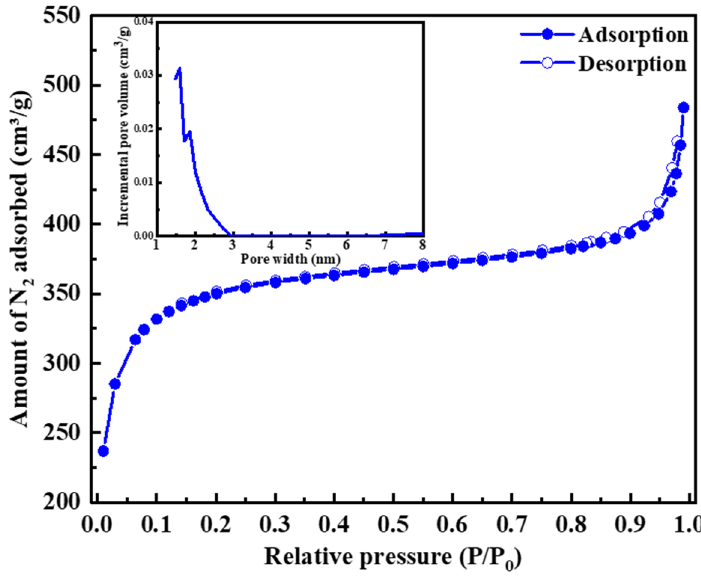
Figure 5. N 2 adsorption and desorption isotherms of UiO-66-DES at 77 K. The inset is the corre- sponding BJH pore size distribution profiles. ing BJH pore size distribution